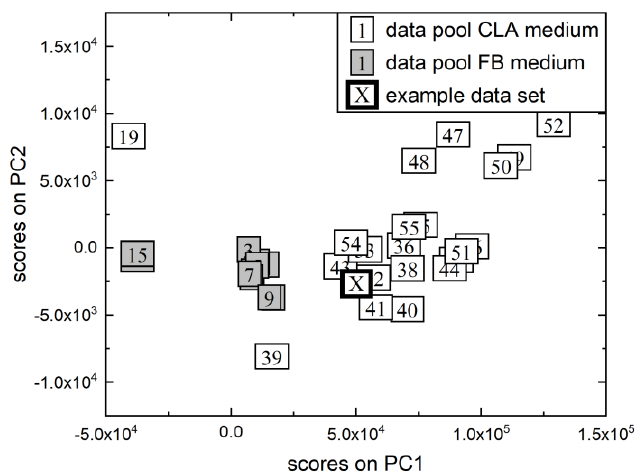
Figure 6. Illustration of the MPCA of the B. subtilis data pool with different media. Each box represents a different data set; the number indicates the batch number. The scores of the data pool’s first two principal components (thin frame and white filling: CLA medium, thin frame and gray filling: FB medium) and the example data set are shown (thick frame). PC = principal component.